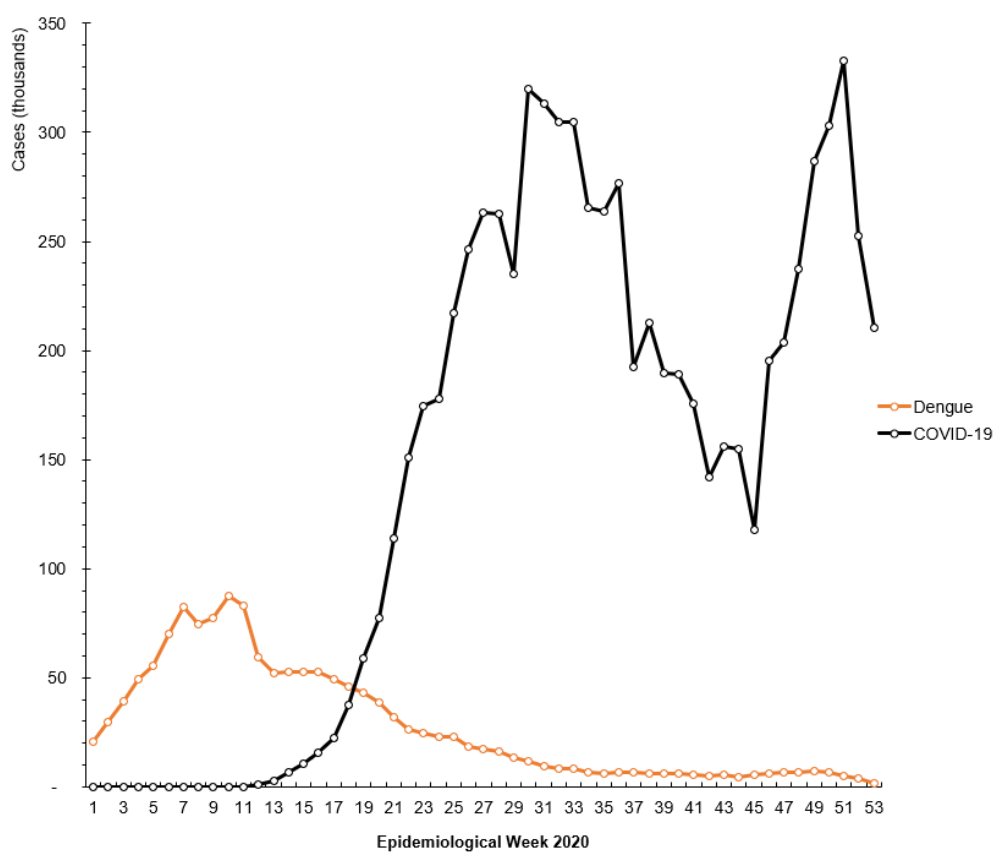
Figure 3. COVID ‐ 19 cases mapped against dengue cases (in thousands) by epidemiological weeks of the COVID ‐ 19 pandemic (from 1 January 2020). the COVID-19 pandemic (from 1 January 2020).